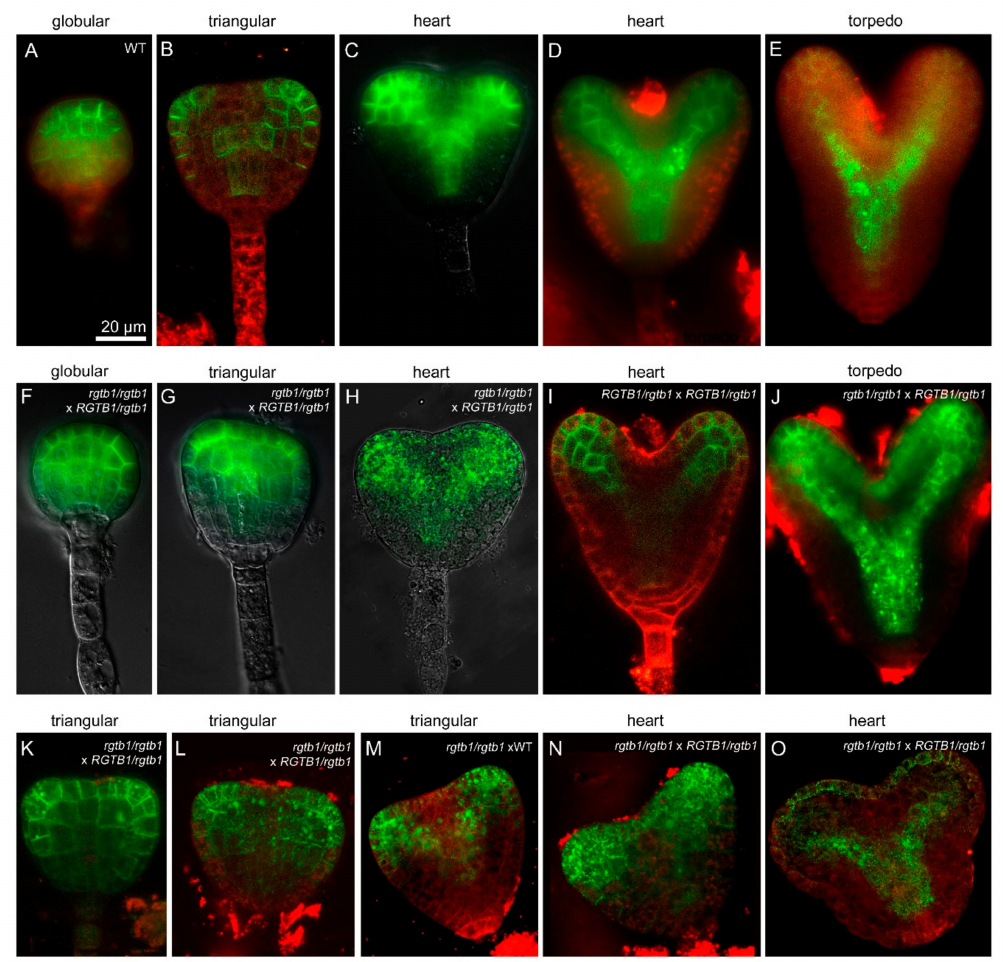
Figure 8. Deformed embryos growing on rgtb1 plants show PIN1 protein mislocalization . pPIN1 :PIN1-GFP expression in embryos in WT ( A – E ) and rgtb1 plants ( F – O ). PIN1-GFP protein is often mislocalized from the plasma membrane to intra- cellular vesicles in embryos formed on rgtb1 plants ( H , J – O ) in comparison to WT embryos ( A – E ). Embryos formed on rgtb1 plants at transition and heart stages of development show a wider domain of pPIN1 :PIN1-GFP expression in the prospective apical meristem ( G – H , K – N ) than WT embryos at corresponding stages ( B , C ). ( B , I , K – O ) CLSM images, pPIN1 :PIN1-GFP sig- nal (green) counterstained with FM4-64 (red) to visualize cell contours; ( A , C – H , J ) fluorescence microscopy, pPIN1 :PIN1-GFP signal (green). The scale bar of 20 µ m in ( A ) is the same in all